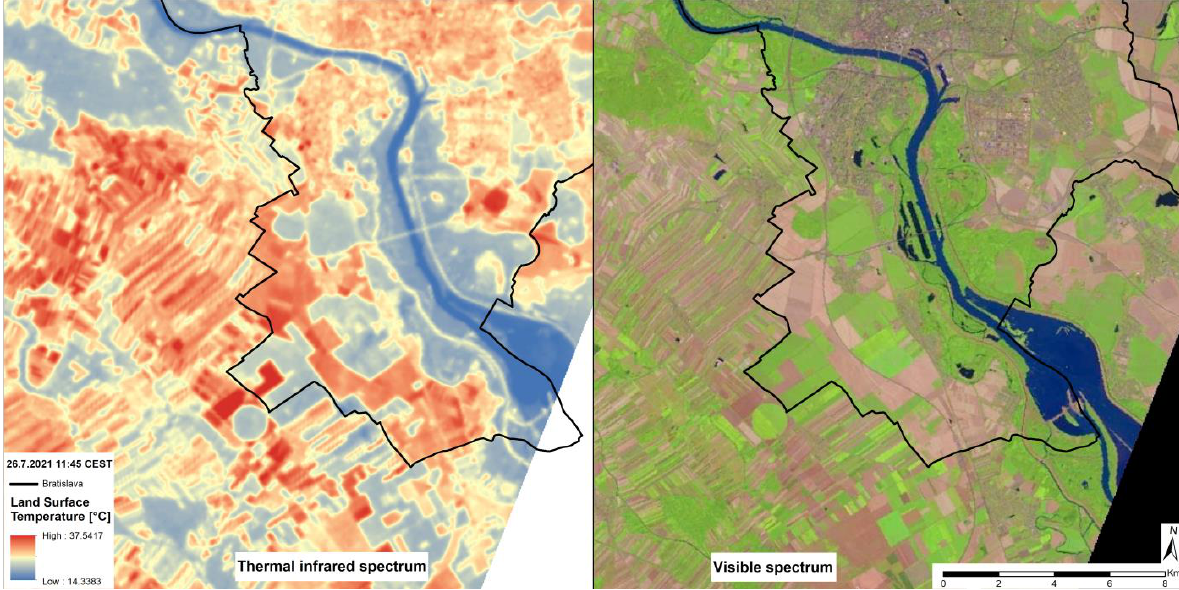
Figure 7. The temperature of surfaces in the Special Protection Area Sysl’ovsk é polia, 26 July 2021, about 11:45CEST (on the left: thermal infrared spectrum, on the right: Visible spectrum) (Landsat-8 image courtesy of the U.S. Geological Survey).